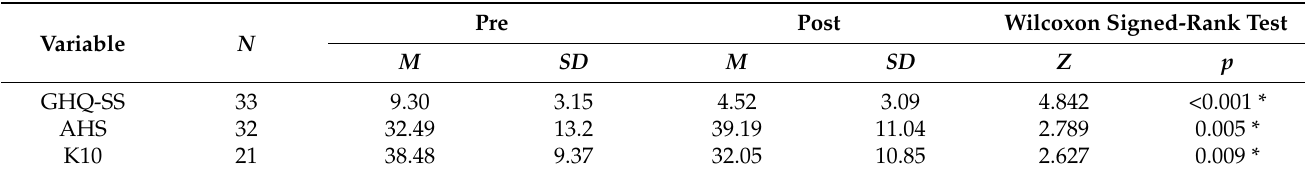
Table 3. Pre-to post-PAUSE participant’s suicidal ideation, hope, and psychological